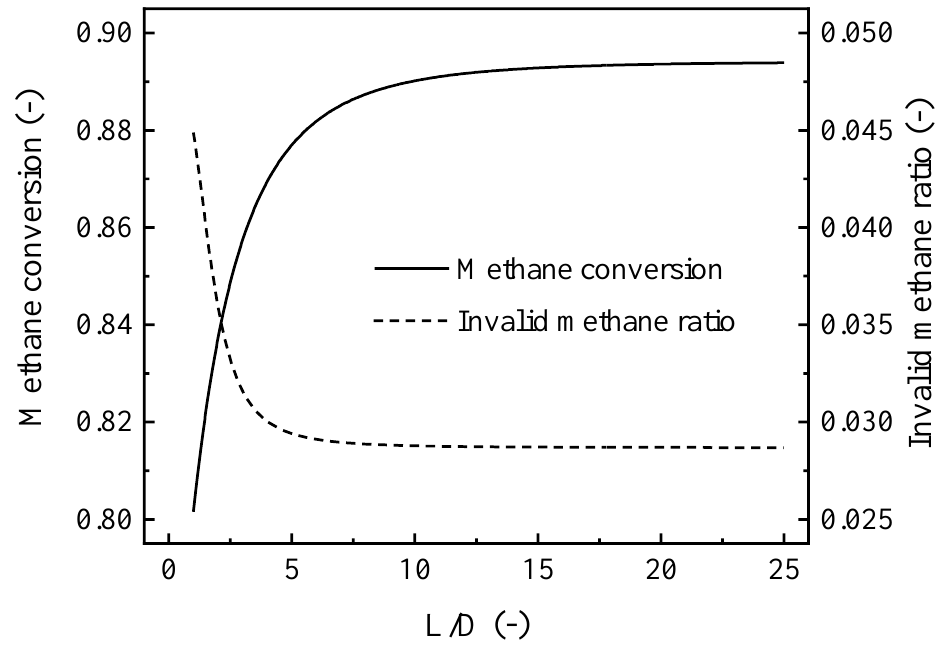
Figure 12. Methane conversion and invalid methane molecule ratio η at different L/D (tube-type, D = 6 mm, 100,000 mL/g-cat/h).